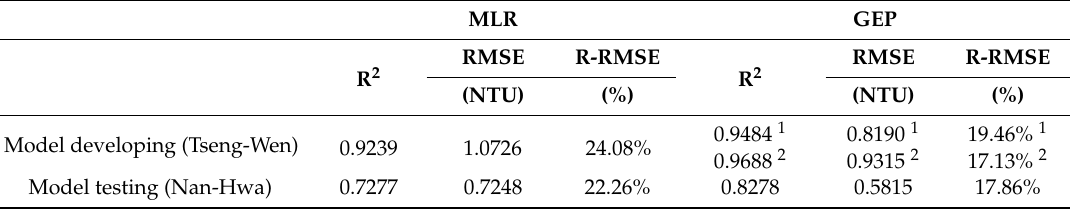
Table 5. The accuracy assessment table of multiple linear regression (MLR) and gene-expression programming (GEP)